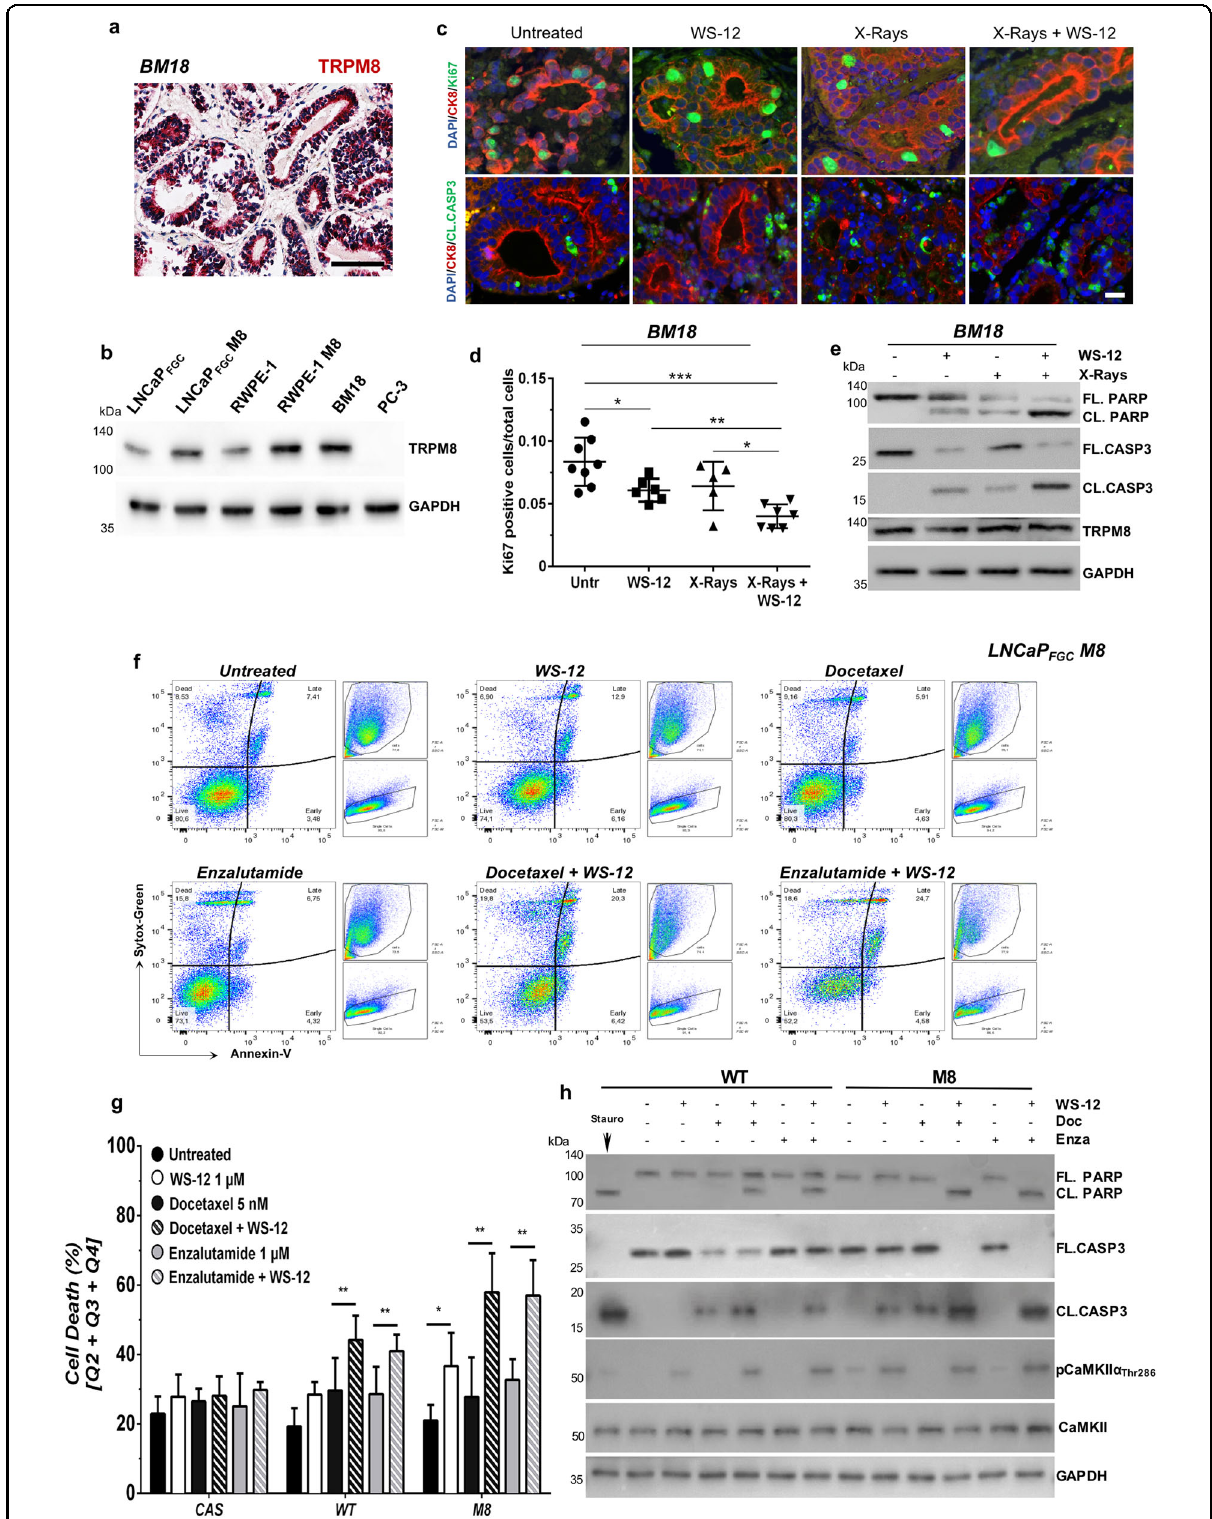
Fig. 6 (See legend on next